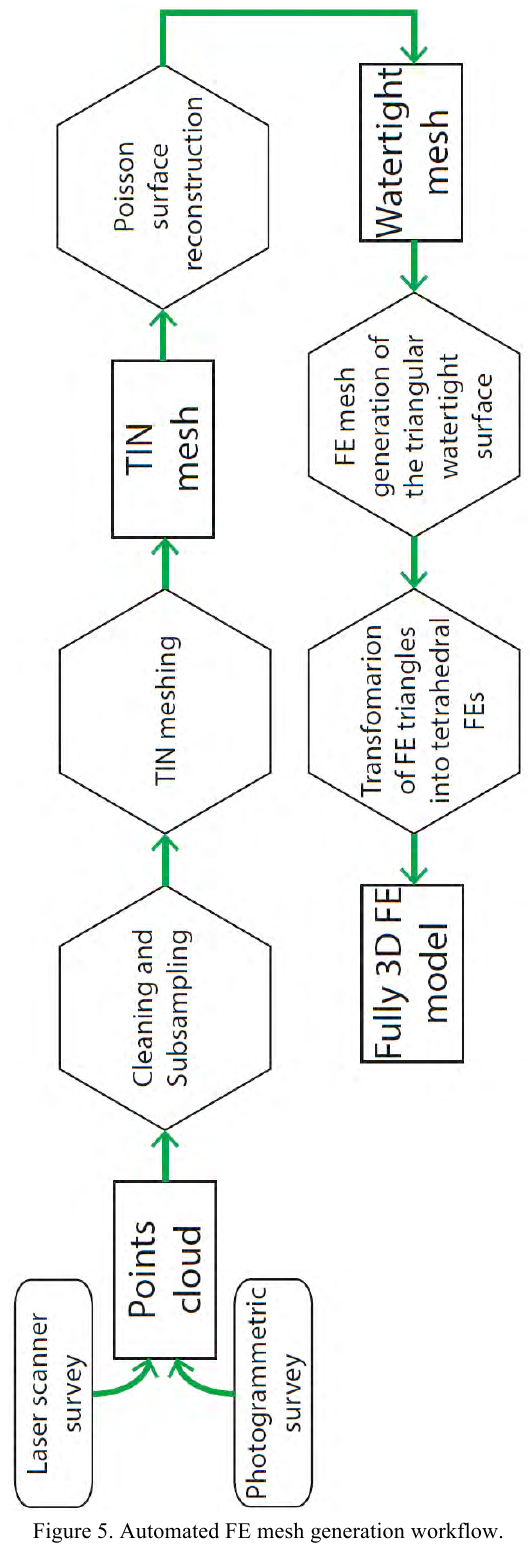
Figure 5. Automated FE mesh generation